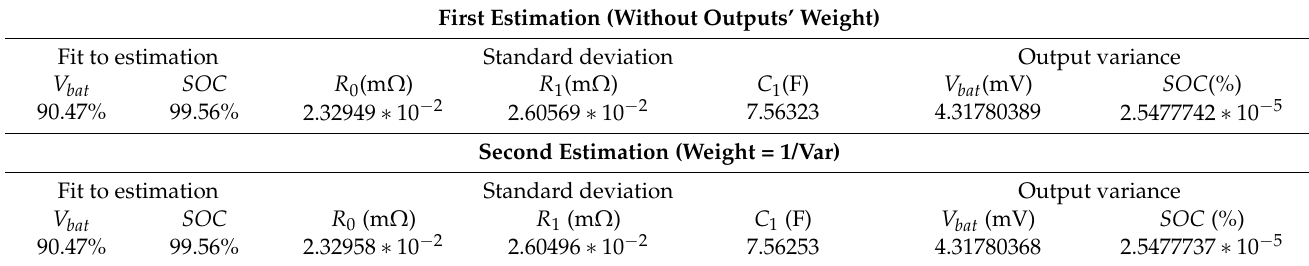
Table 4. Comparison between the first estimation without weight and the second estimation with weight in the outputs.